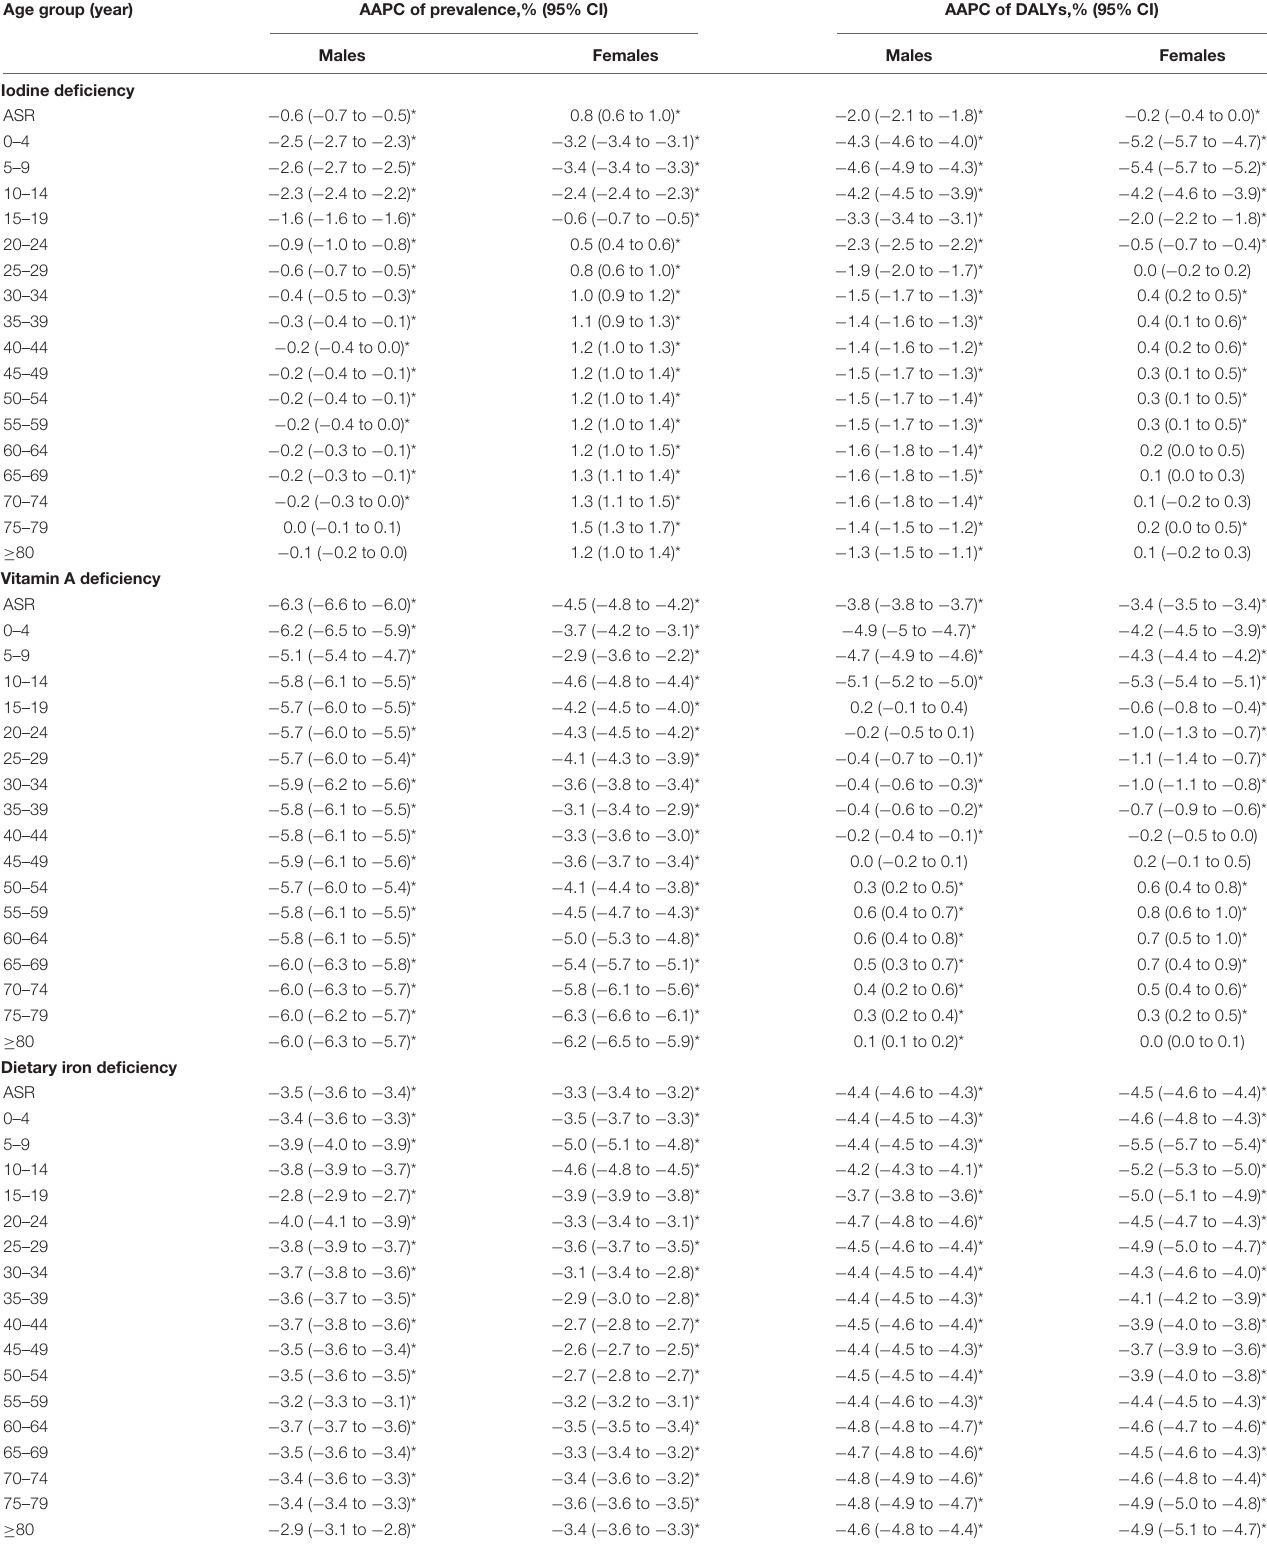
TABLE 1 | The average annual percentage changes (AAPCs) in the prevalence of and DALYs due to iodine deficiency, vitamin A deficiency and dietary iron deficiency,